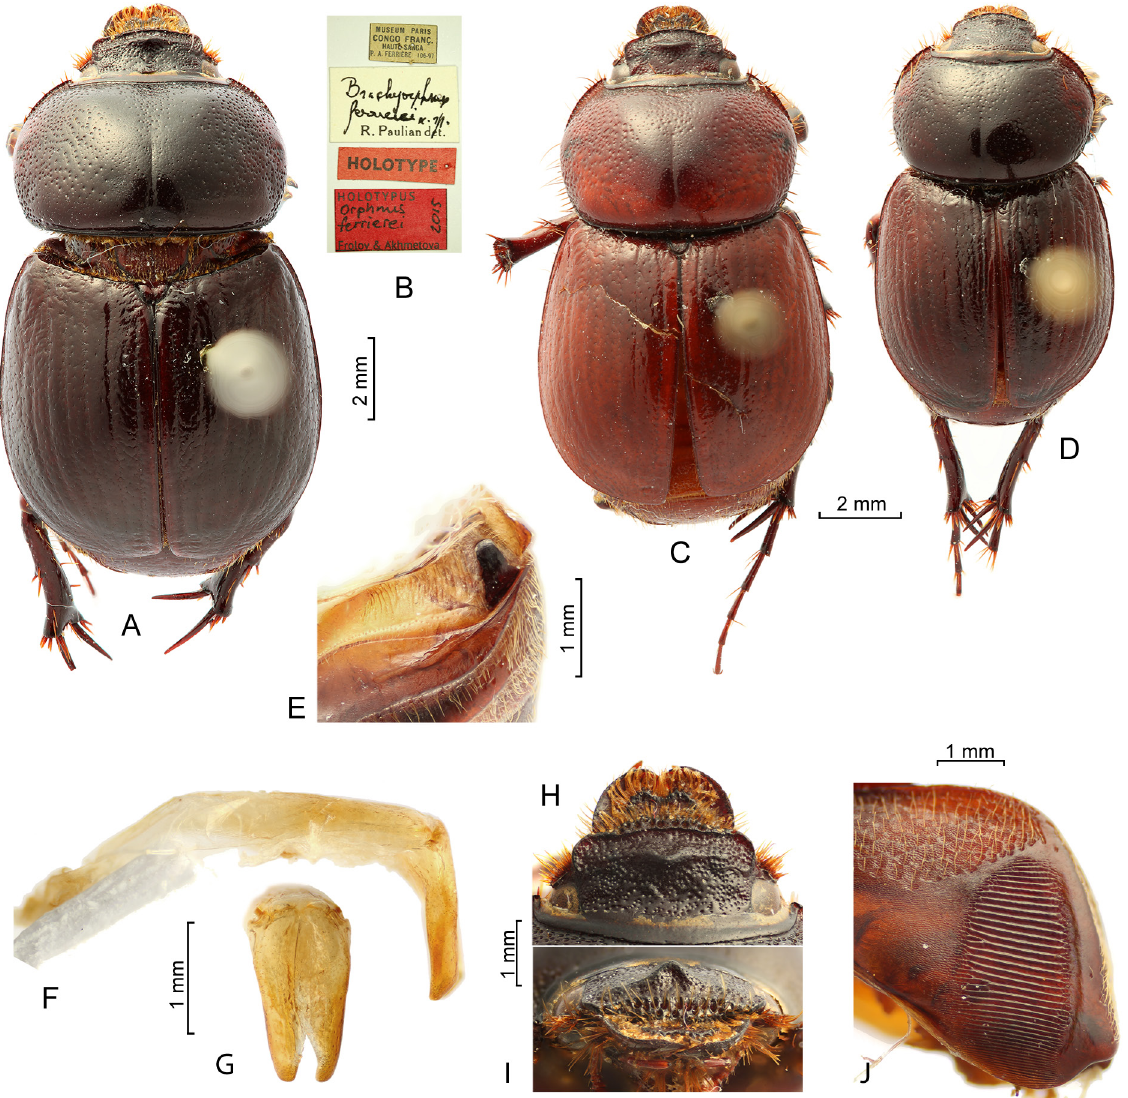
Fig. 4. Orphnus ferrierei sp. nov. A , C–D . Habitus. B . Labels of holotype. E . Abdomen in